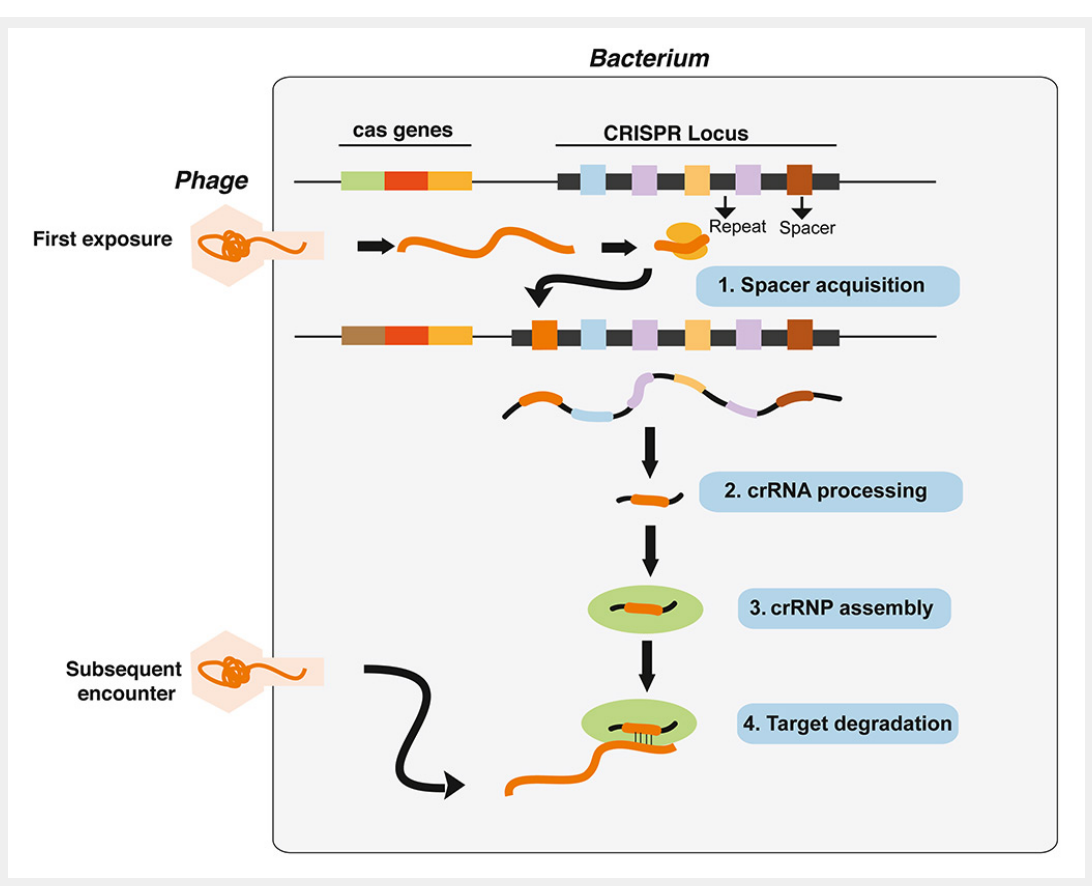
CRISPR directed antiviral immunity in bacteria. An outline of how CRISPR-mediate antiviral immunity functions in bacteria. Upon defective viral infection, short viral sequences are inserted into the CRISPR array, where they become the new “spacers” flanked by repeats. The spacers, thus provide a memory of past infection. To ensure immunity to subsequent infection, the entire CRISPR array is transcribed and processed into short crisprRNAs (crRNAs), which form complexes with other “effector” Cas proteins and guide them to degrade invading viral DNA or RNA in a sequence-specific